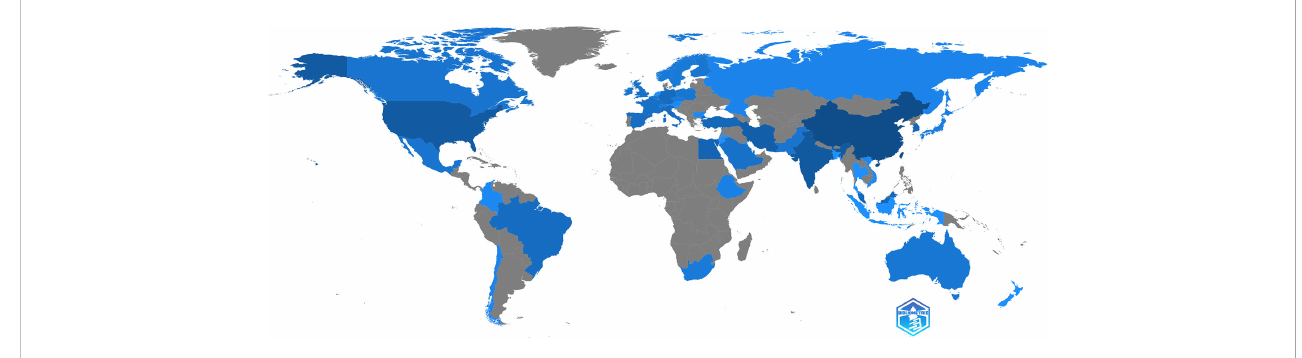
FIGURE 3 Map of global